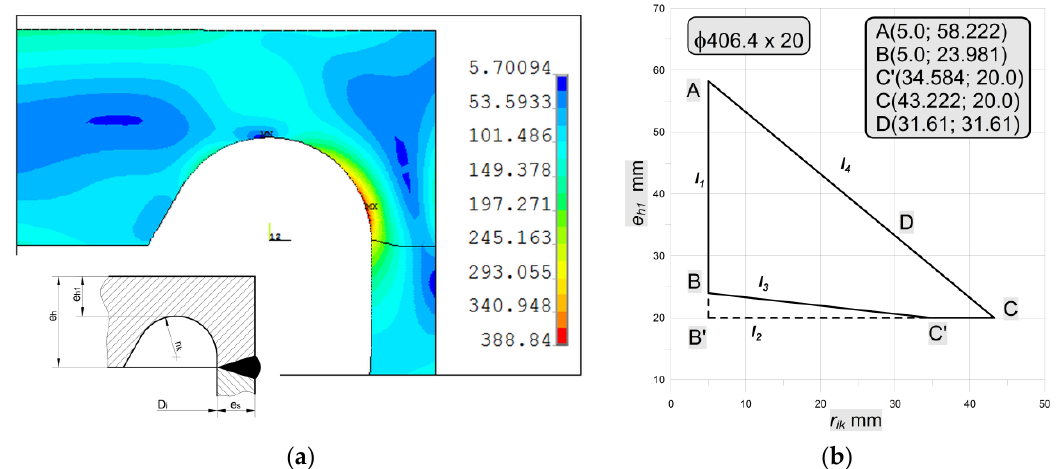
Figure 21. Bottom type “e”: ( a ) distribution of equivalent stresses in the groove for optimally chosen r ik ; ( b ) Admissible area for head type “e”, for pipe with dimensions Ø406.4 × 20 mm.